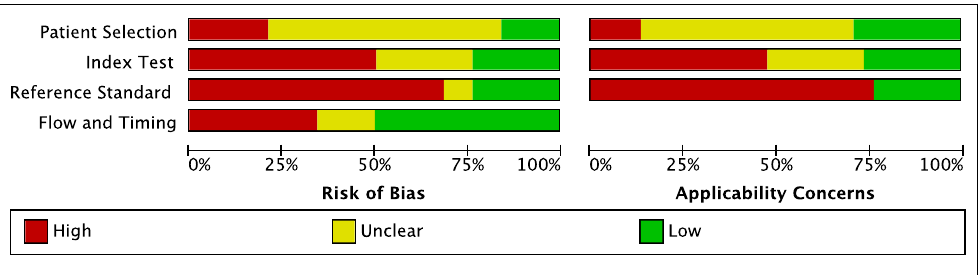
Figure 2. Quality assessment (QUADAS) graph of clinical studies.